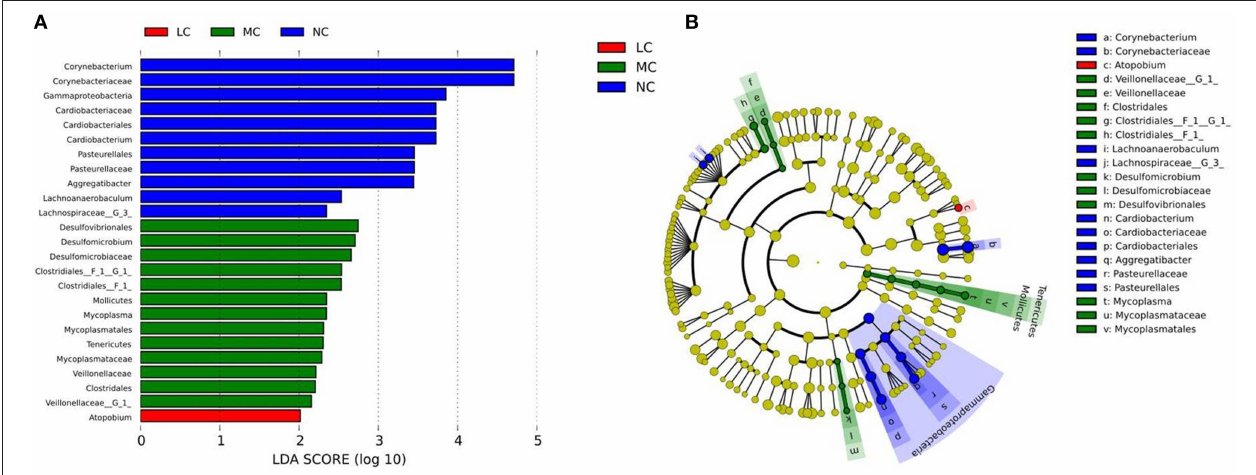
FIGURE 5 | Comparison of microbial variations at the genus level, using the LEfSe online tool. (A) Histogram of the LDA scores for differentially abundant features among groups. The threshold on the logarithmic LDA score for discriminative features was set to 2.0. (B) Cladogram for taxonomic representation of significantly differences among groups. Differences are represented in the color of the most abundant taxa (red indicating LC, green indicating MC, blue indicating NC, and yellow indicating non-significant).